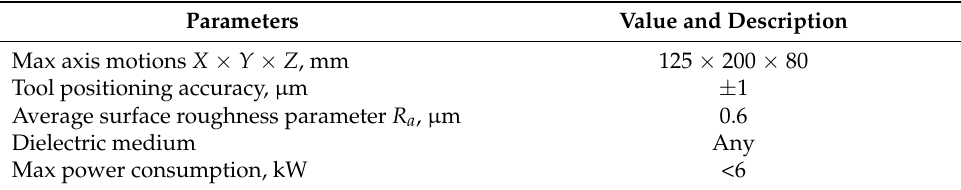
Table 1. Main characteristics of wire electrical discharge machine ARTA 123